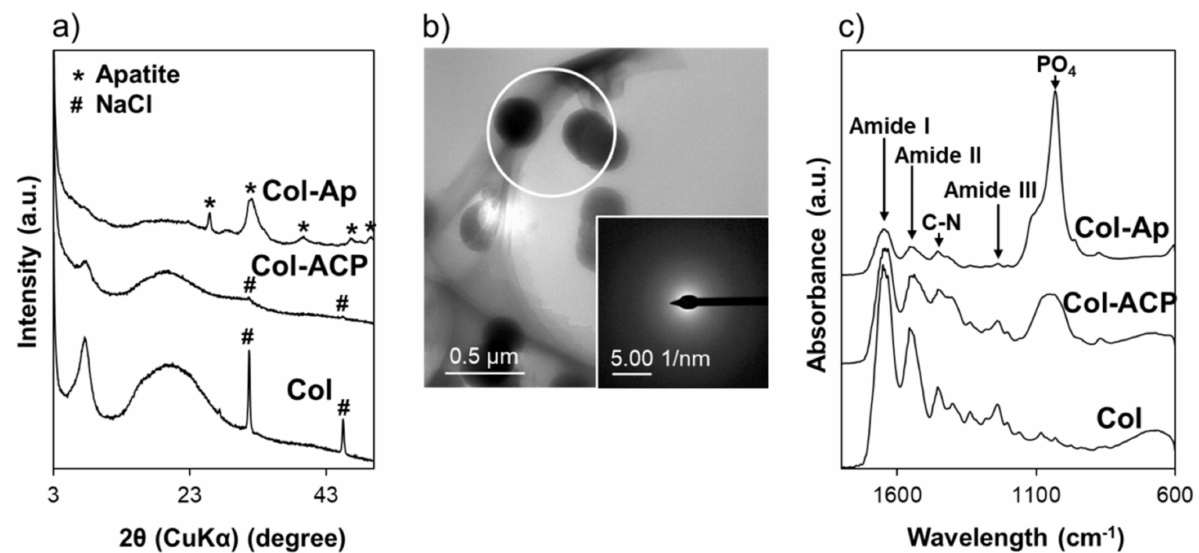
Figure 2. ( a ) XRD patterns of Col, Col-ACP, and Col-Ap surfaces; ( b ) TEM image and SAED pattern of a cross-section of Col-ACP; ( c ) FT-IR spectra of Col, Col-ACP, and Col-Ap